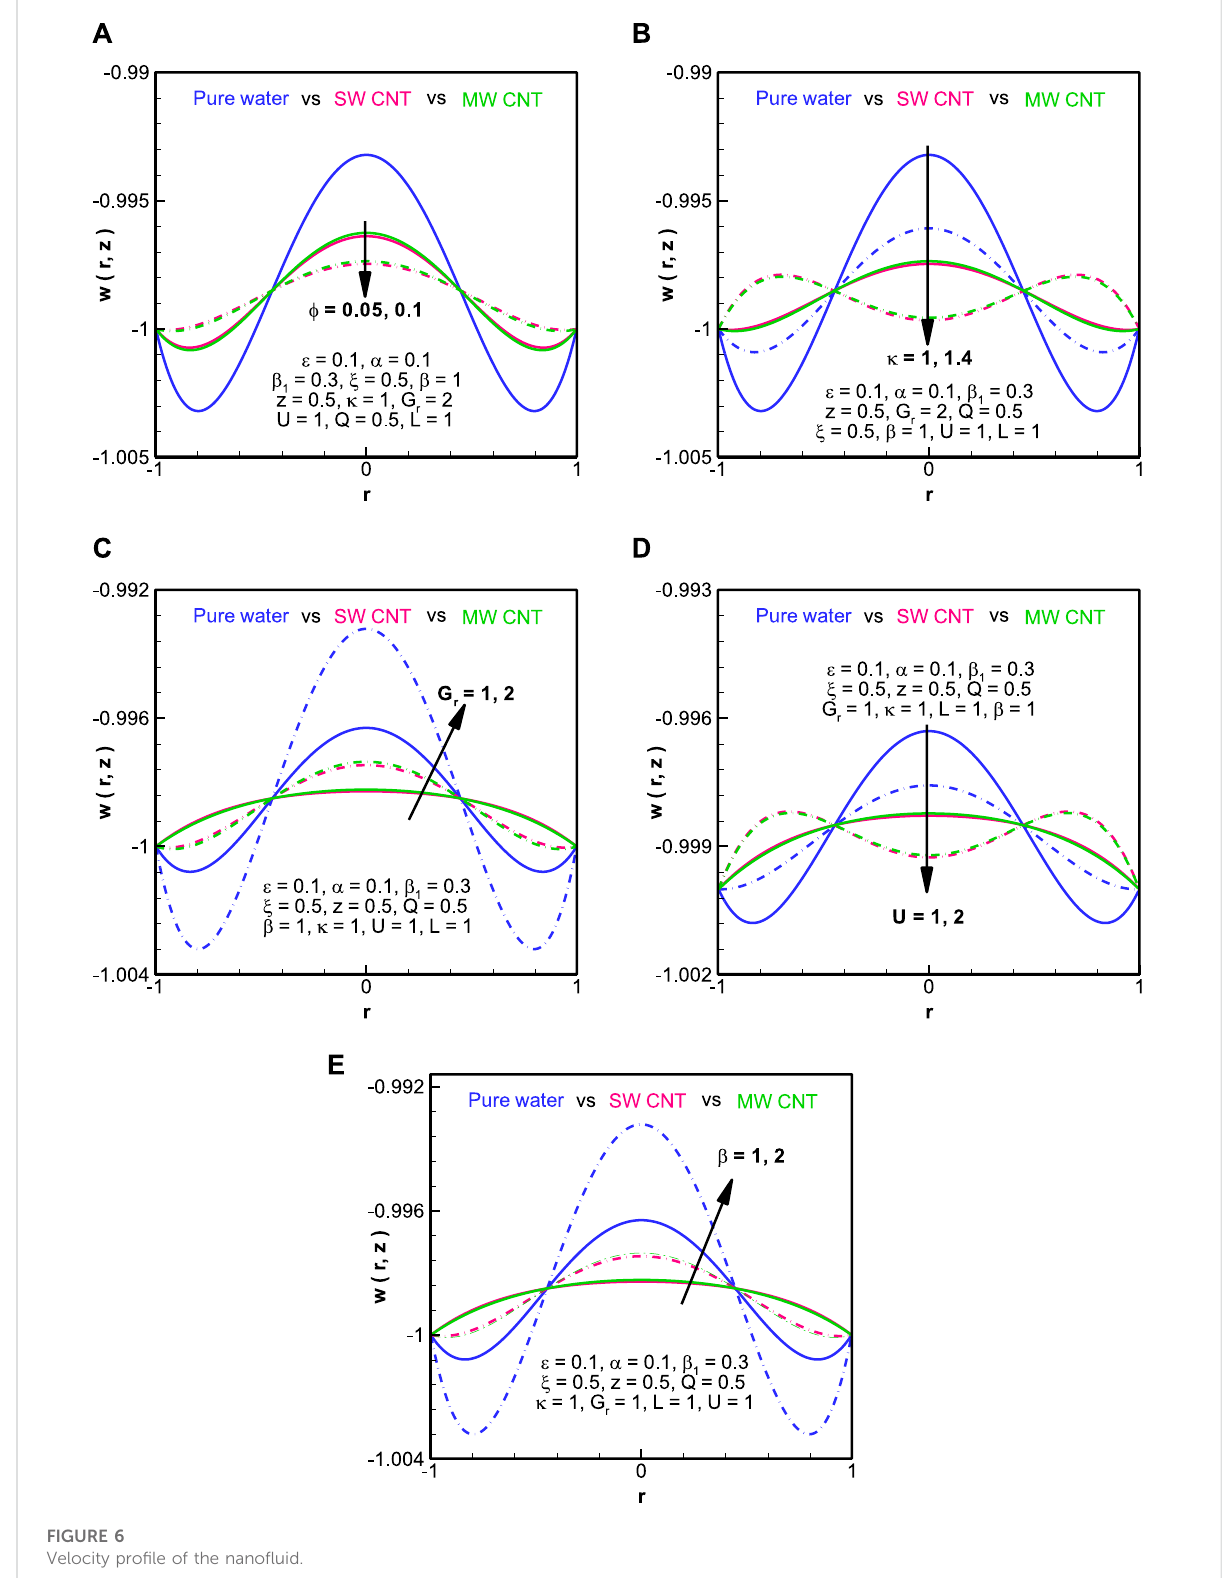
FIGURE 6 Velocity pro fi le of the nano fl